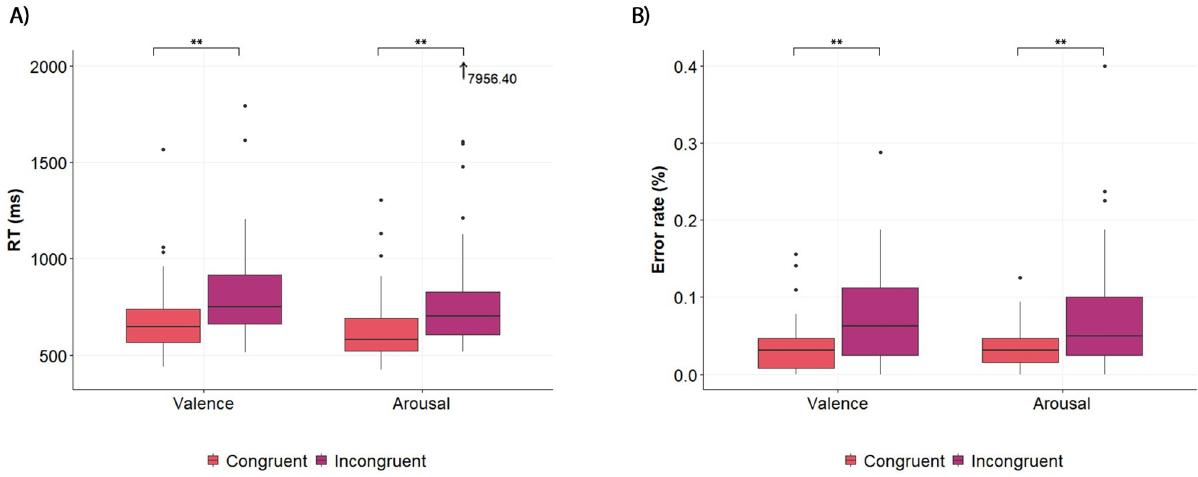
Fig 8. Experiment 2 results. Mean response times (A) and mean error rates (B) in the congruent pairings and incongruent pairings in the valence and arousal dimensions. Error bars represent the standard errors of the mean. The asterisks indicate statistically significant differences at p < .01 ( �� ).